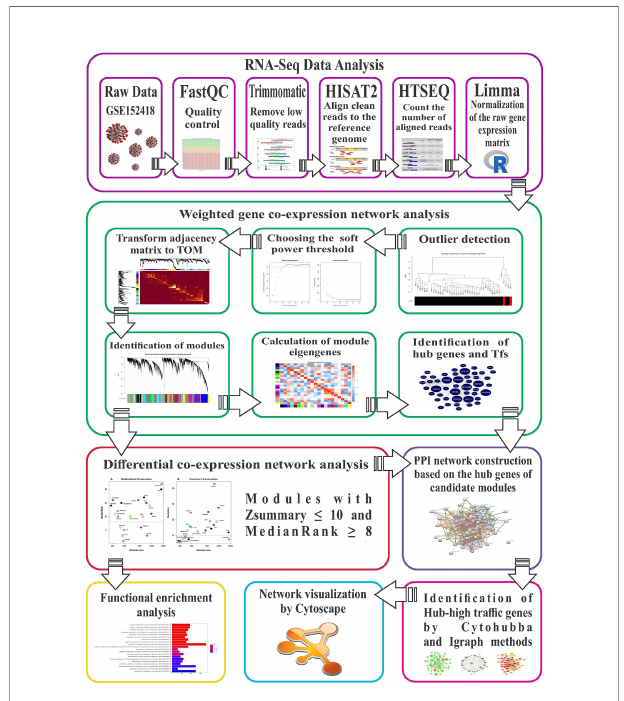
FIGURE 1 | The stringent step-by-step pipeline of the RNA-seq data analysis and differential co-expression network approach in this